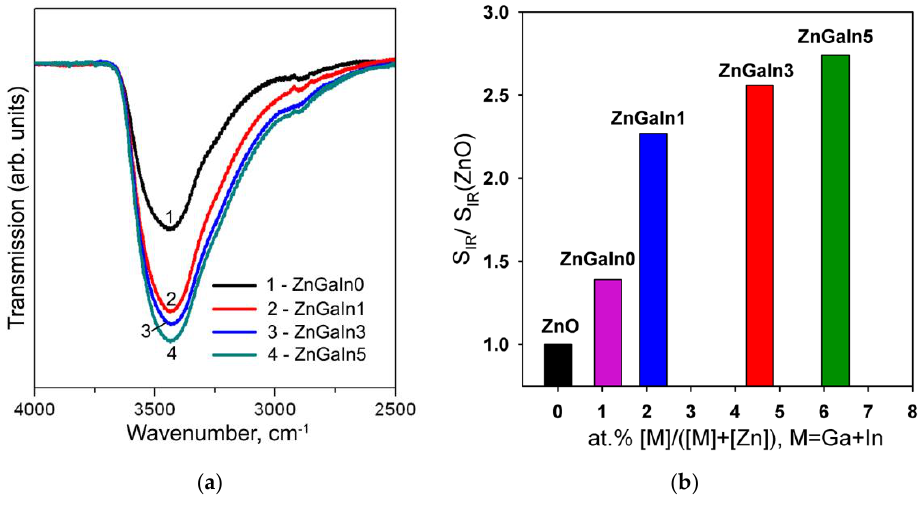
Figure 5. ( a ) IR spectra of investigated samples in the spectral region 2500–4000 cm −1 : (1) ZnGaIn0, (2) ZnGaIn1, (3) ZnGaIn3, (4) ZnGaIn5; ( b ) The dependence of the concentration of surface hydroxyl groups, represented as a peak area corresponding to OH stretching vibrations (S IR ) normalized to the corresponding value for bare ZnO (S IR (ZnO)), on impurity content.